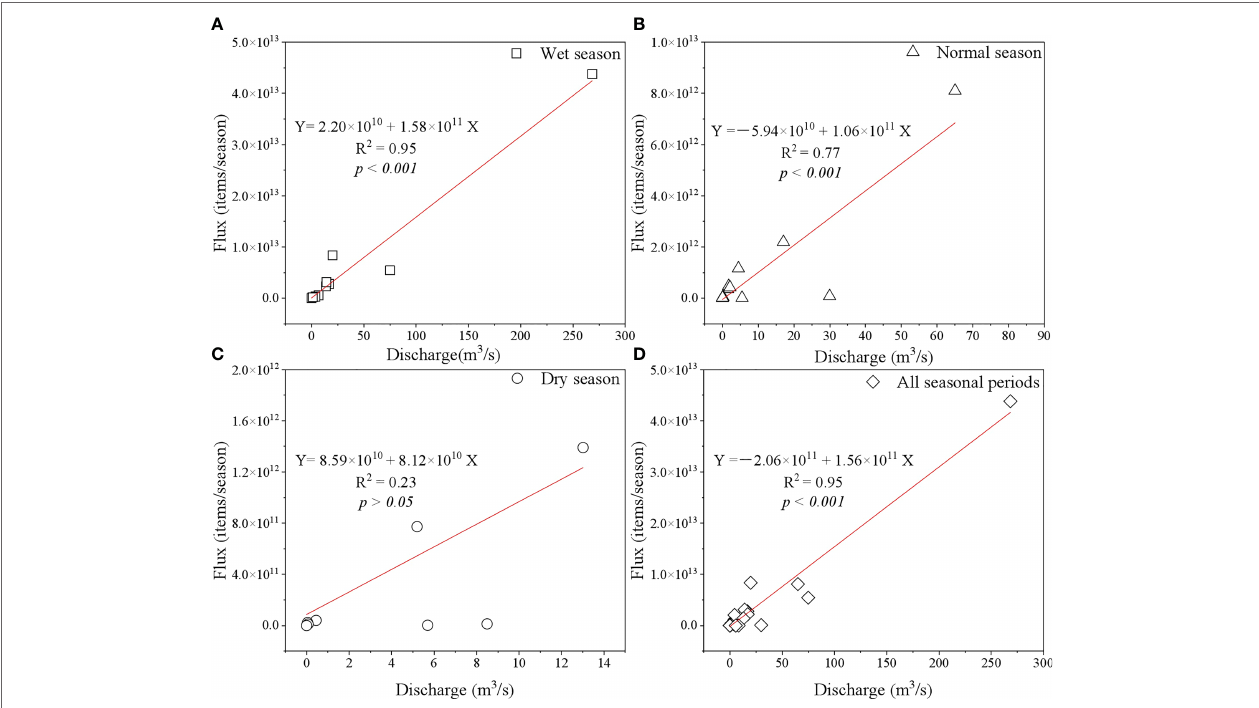
FIGURE 7 | Linear regression relationships between river discharge and flux of MPs in ZJB. (A) Wet season, (B) Normal season, (C) Dry season, and (D) All seasonal